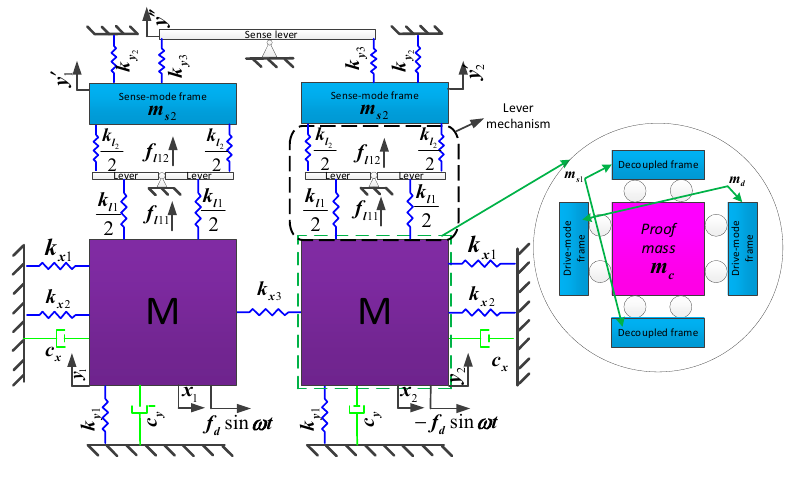
Figure 2. Model of type A.